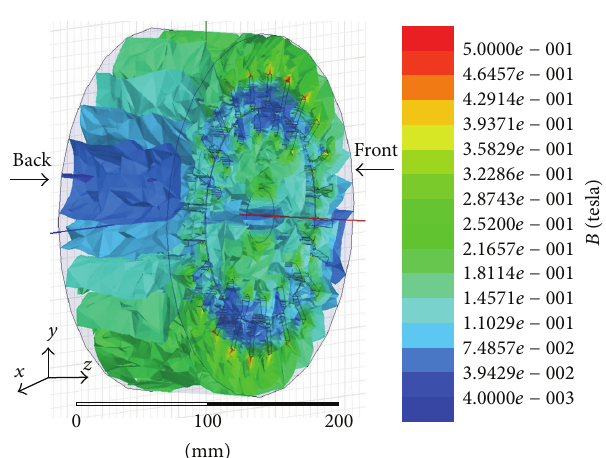
between theaxial UMP and AAGE areopposite. More- over, a new calculation method combining (4) and (6) is proposed. The new method is to take the root mean